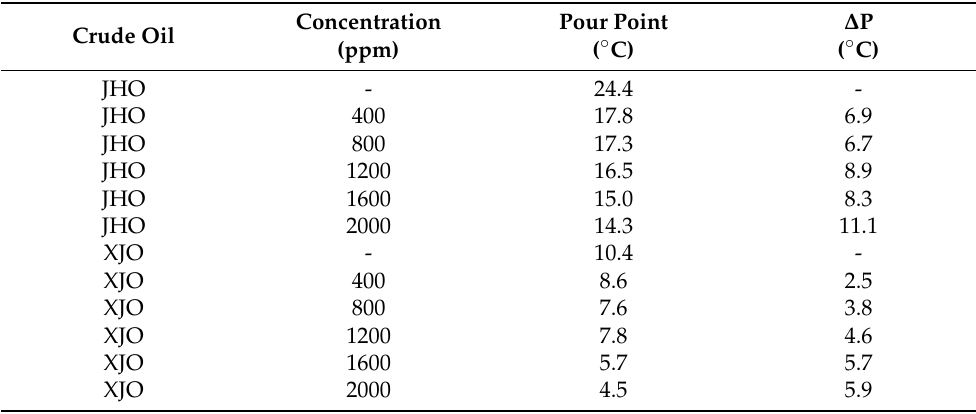
Table 4. Influence of CA S H on the pour point of crude oil. Crude